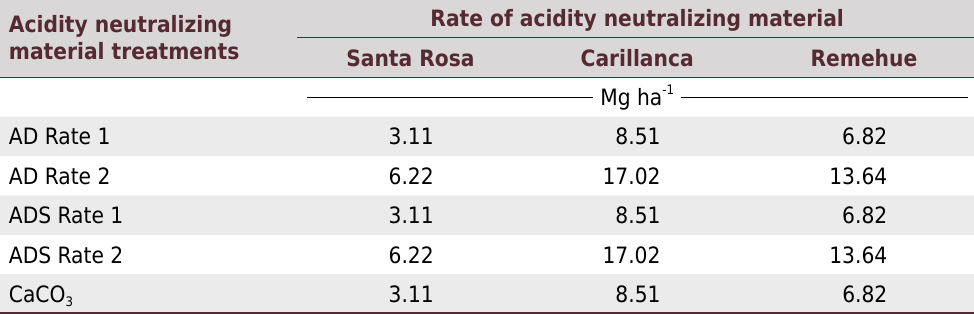
Table 2. Rate of acidity neutralizing materials used in each soil and treatment Acidity neutralizing material